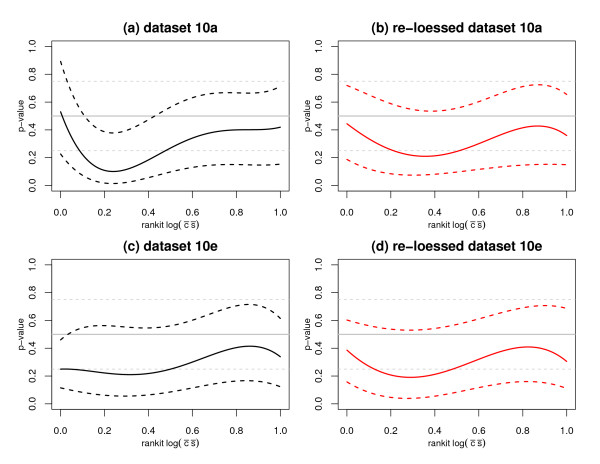
Estimates of the null p-value quartiles vary as a function of signal intensity for datasets 10a (a, b) and 10e (c, d); although less so for the re-loessed data. The x-axes correspond to the rankit (i.e., rank of valuetotal#of values+1
 MathType@MTEF@5@5@+=feaafiart1ev1aaatCvAUfKttLearuWrP9MDH5MBPbIqV92AaeXatLxBI9gBaebbnrfifHhDYfgasaacH8akY=wiFfYdH8Gipec8Eeeu0xXdbba9frFj0=OqFfea0dXdd9vqai=hGuQ8kuc9pgc9s8qqaq=dirpe0xb9q8qiLsFr0=vr0=vr0dc8meaabaqaciaacaGaaeqabaqabeGadaaakeaadaWcaaqaaiabbkhaYjabbggaHjabb6gaUjabbUgaRjabbccaGiabb+gaVjabbAgaMjabbccaGiabbAha2jabbggaHjabbYgaSjabbwha1jabbwgaLbqaaiabbsha0jabb+gaVjabbsha0jabbggaHjabbYgaSjabcocaJiabb+gaVjabbAgaMjabbccaGiabbAha2jabbggaHjabbYgaSjabbwha1jabbwgaLjabbohaZjabgUcaRiabigdaXaaaaaa@52A7@) of the log of the product of the expression means. The y-axes correspond the observed two-sided p-values. Solid and dashed grey lines indicate the theoretical medians and quartiles, respectively. The null p-values were modeled as a function of a 4th order polynomial for rankit intensity. Black and red lines correspond to the quantile regression fits for τ = 0.5 (solid) and τ = 0.25, 0.75 (dashed). Portions of this figure appear with permission in the response to [2].